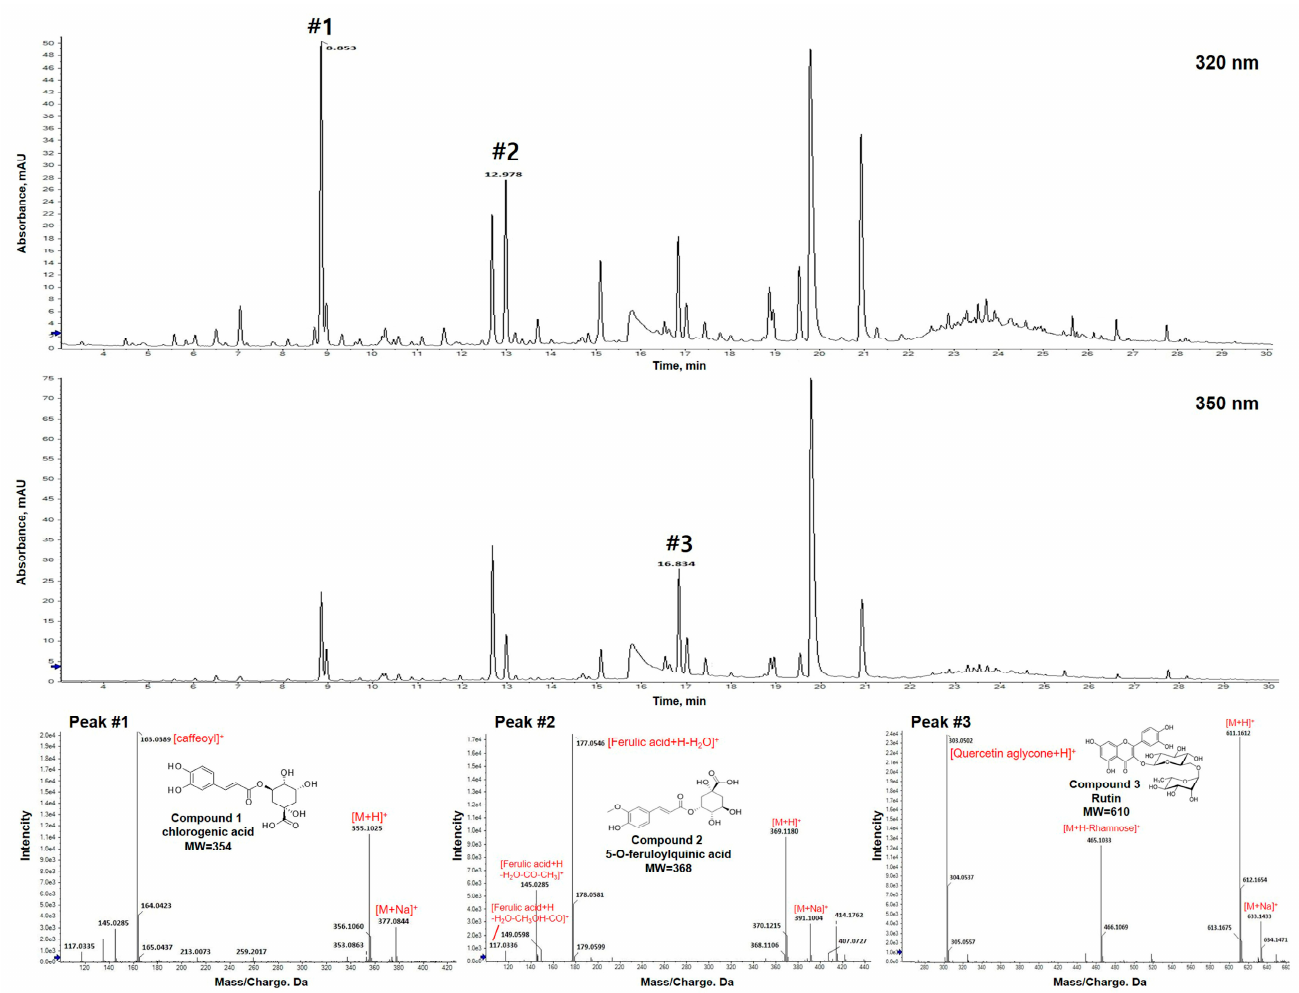
Figure 1. LC/MS analysis and identification of OJE. Phenolic acid and flavonoid derivative compounds in OJE. Numbers refer to the main peaks identified: #1, chlorogenic acid; #2, 5-O-feruloylquinic acid; #3, rutin (quercetin–3–rutinoside).